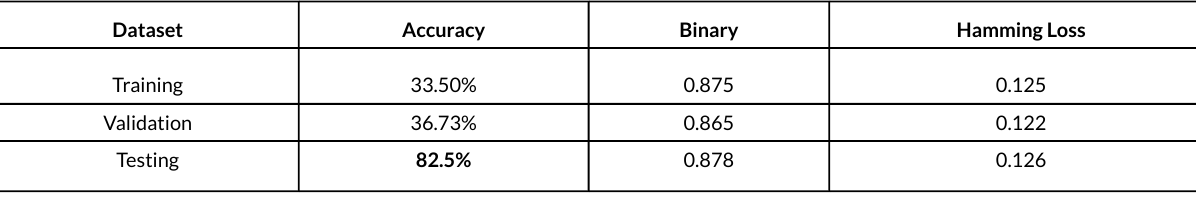
Table 2. Proposed feed-forward architecture performance.